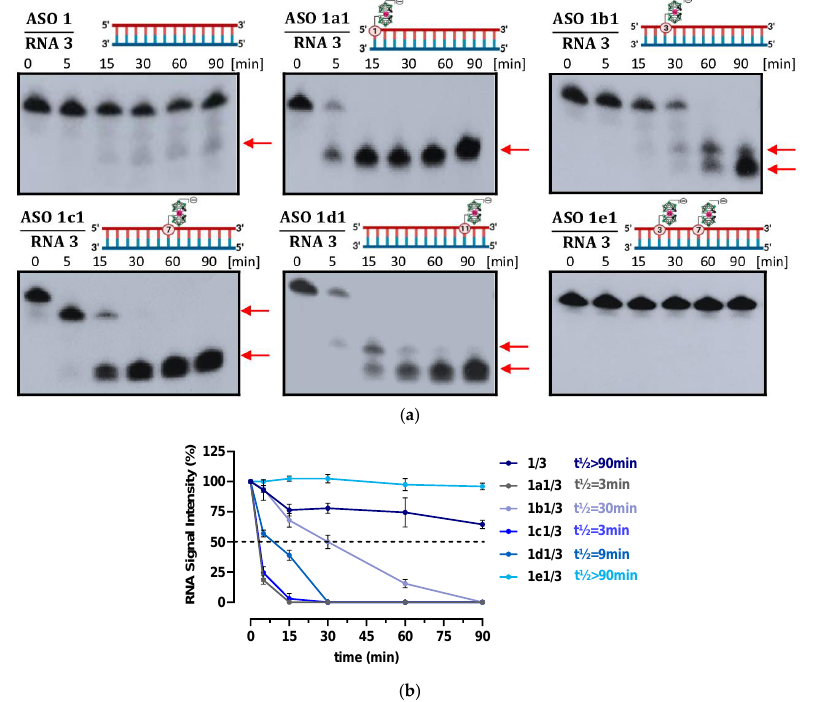
Figure 2. Autoradiograms of 20% denaturing PAGE, showing the cleavage kinetics of 5′ -[ 32 P]-labelled RNA- 3 in duplexes containing ASO 1 or B-ASO- 1 ( 1a 1 , 1b 1 , 1c 1 , 1d 1 , 1e 1 ) (panel a ) after treatment with RNase H (1 µL of 0.3 U/µL stock solution) after 0, 5, 15, 30, 60, and 90 min. Densitometric analyses of the content of the intact 5′ -[ 32 P]-RNA 3 substrate were performed using three independent PAGE analysis experiments (panel b ). Red arrows indicate the products of the degraded 5′ -[ 32 P]- RNA. Experimental conditions are described in the Materials and Methods section. Figure were created in BioRender (https://biorender.com/, accessed on 23 June 2022) and GraphPad Prism (https://www.graphpad.com/, accessed on 15 August 2022).